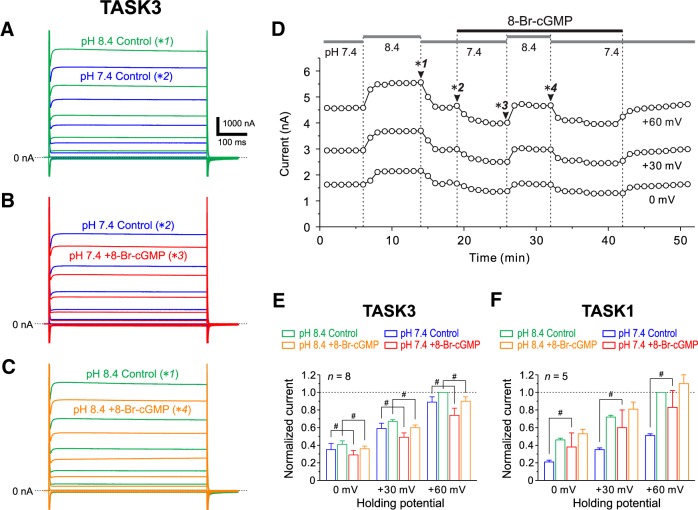
8-Br-cGMP inhibits cloned TASK3 channels. A, Superimposed TASK3 currents evoked by voltage steps ranging between −150 and +60 mV in 30 mV steps applied at a holding potential of −90 mV at pH 8.4 and 7.4. The respective current traces were obtained at the time points indicated with *1 and *2 in D. B, Superimposed TASK3 currents obtained at pH 7.4 before (blue traces) and during (red traces) the application of 8-Br-cGMP. The respective current traces were obtained at the time points indicated with *2 and *3 in D. C, Superimposed TASK3 currents obtained at pH 8.4 before (green traces) and during the application of 8-Br-cGMP (orange traces). The respective current traces were obtained at the time points indicated with *1 and *4 in D. D, Plots of TASK3 currents at 0, +30, and +60 mV against time. Gray horizontal bars represent the timing and duration of perfusion of the extracellular solutions at respective pH, and the black horizontal bar represents the timing and duration of the addition of 100 μm 8-Br-cGMP. Arrowheads indicate the time points at which the respective current responses shown in A–C were obtained. E, The normalized TASK3 currents recorded before and during the application of 8-Br-cGMP at pH 7.4 (blue and red columns, respectively) and those recorded before and during the application of 8-Br-cGMP at pH 8.4 (green and orange columns, respectively; n = 8). All of the TASK3 currents are normalized by that obtained before the application of 8-Br-cGMP at pH 8.4. #p < 0.05, two-way ANOVA followed by Fisher’s PLSD. F, The normalized TASK1 currents recorded before and during the application of 8-Br-cGMP at pH 7.4 (blue and red columns, respectively) and those recorded before and during the application of 8-Br-cGMP at pH 8.4 (green and orange columns, respectively; n = 5). All of the TASK1 currents are normalized by that obtained before the application of 8-Br-cGMP at pH 8.4. #p < 0.05, two-way ANOVA followed by Fisher’s PLSD.